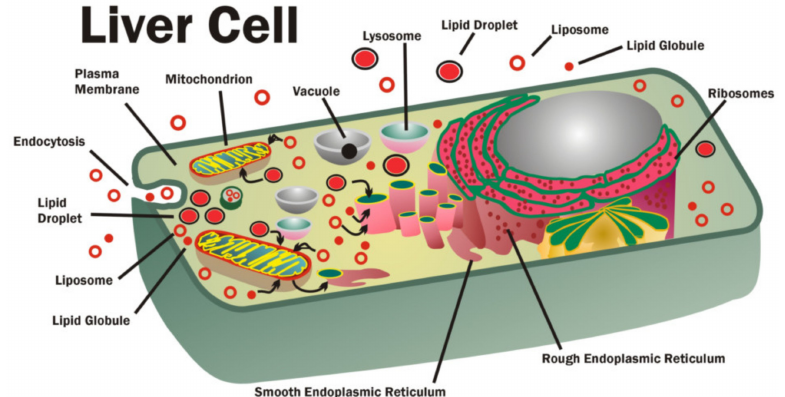
Figure 3. A few of the phospholipid transport structures involved in the delivery of membrane phospholipids and other lipids to intracellular membranes, and the reverse of this process to remove damaged lipids. A liver cell is shown with internal lipid transfer and storage systems, such as lipid micelles, globules, vesicles, chylomicrons and lipid droplets. These various lipid transport and trans- fer structures can bind to different intracellular membranes and transfer glycerolphospholipids and other lipids, and can pick up damaged lipids for eventual delivery to the extracellular environment. Not shown in the figure are lipid transport/transfer by direct adjacent membrane-to-membrane contact and lipid droplet-, globule-, chylomicron- and vesicle-to-membrane contact by temporary fusion with adjacent intracellular membranes. Both the forward and reverse processes appear to be driven by mass action or bulk flow mechanisms. (Modified from Nicolson et al.